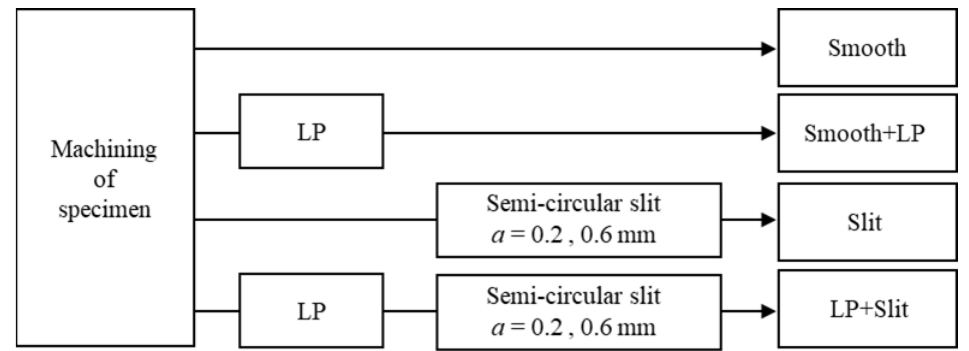
Figure 2. Flowchart of the test specimen machining process.